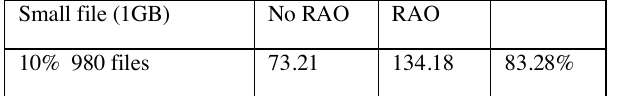
Table 8 Random Spacing, RAO effects for 1 GB none aggregated files